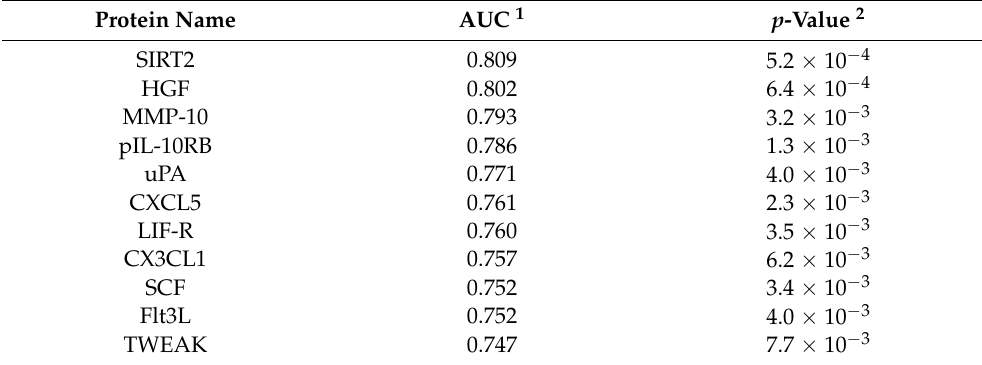
Table 1. List of most discriminatory proteins between AD-MCI and OND by univariate analysis. Protein Name